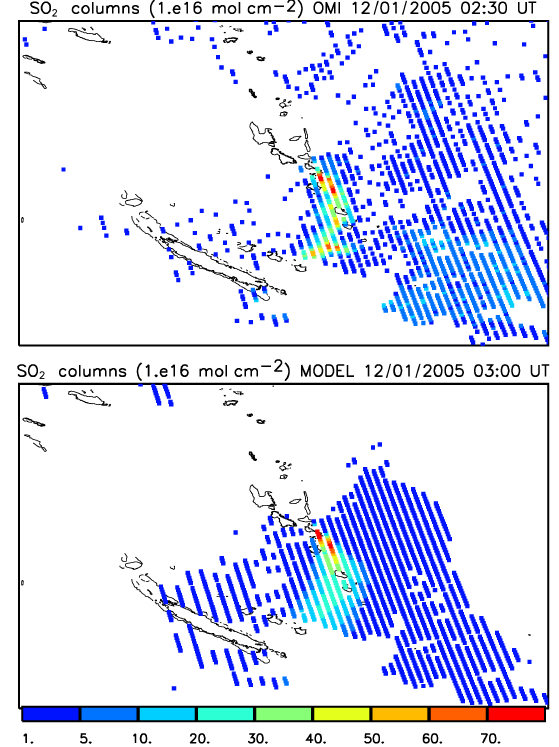
Figure 10. Top: OMI SO 2 columns (1 × 10 16 moleculecm − 2 ) for the 12 January 2005 at 02:30UTC. Bottom: simulated SO 2 columns (1 × 10 16 moleculecm − 2 ) (S1_HighT) from the 10km × 10km grid for the 12 January 2005 at 03:00UTC interpolated onto the OMI